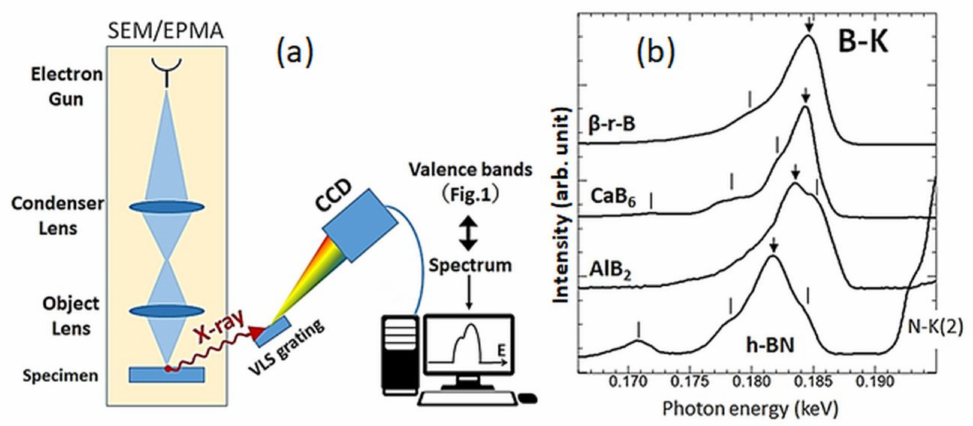
Figure 2. ( a ) SXES-EPMA system used. The SXES spectrometer is composed of gratings and a CCD detector, which enables a parallel detection in a certain energy range. ( b ) B K-emission spectra of pure boron and boron compounds. Peak energy position (arrows) and shoulder structures (line) are different each other, reflecting different chemical bonding states owing to different crystal structures.